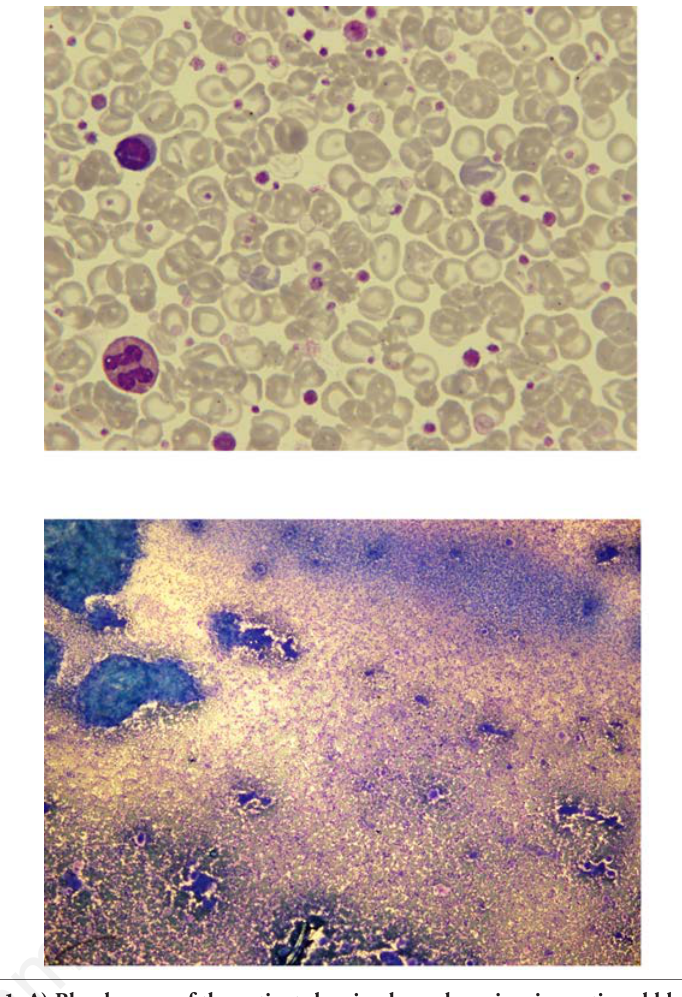
Figure 1. A) Blood smear of the patient showing hypochromic microcytic red blood cells with anisocytosis and poikilocytosis compatible with thalassemia. Platelets were marked- ly increased with a variation in size and staining, including agranular platelets. B) Bone marrow aspirate revealing hypercellular marrow of 90%. There was panmyelosis or a pro- liferation of erythroid, granulocytic and megakaryocytic lineages with effective matura- tion. Megakaryocytes were increased in size with pleomorphism, and also nuclear lobu- lation. Significant platelet clumping was also seen.